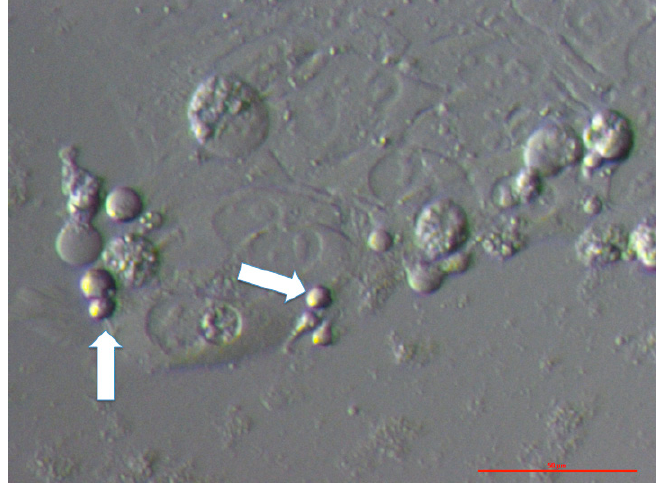
Figure 3. VSEL-like stem cells (arrows) with diameters of up to 5 μ m among the cells of an embryo at the blastocyst stage that spontaneously separated after a biopsy for preimplantation genetic diagnosis in the in vitro fertilization programme. Embryonic cells began to attach to the dish bottom and spread. Red bar: 50 μ m.